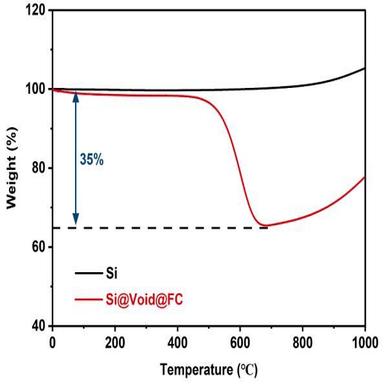
TG curves of Si and Si@Void@FC.